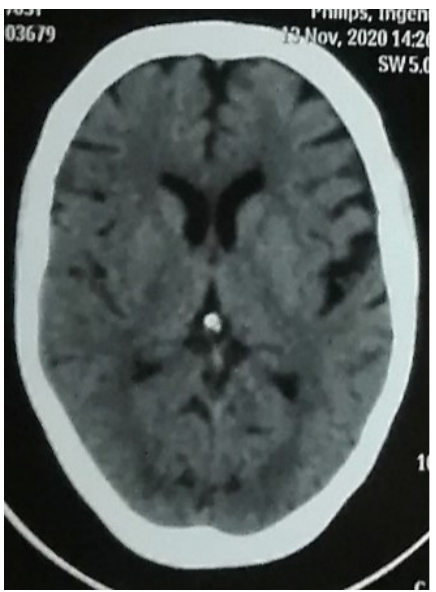
Figure 1 . Non-contrast-enhanced CT brain showing cerebral atrophy with no parenchymal brain lesion.